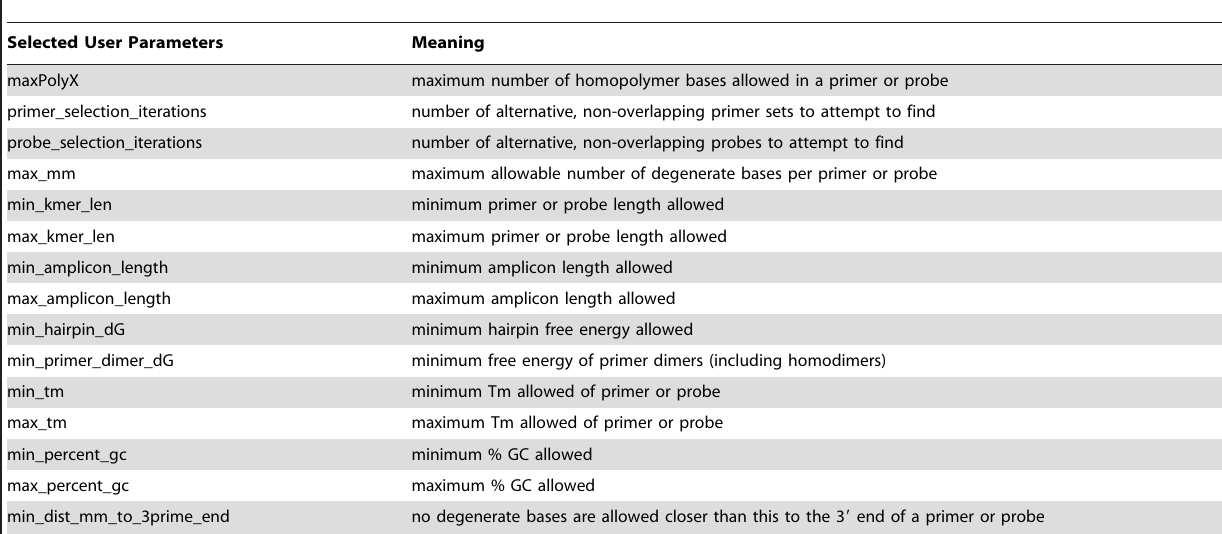
Table 1. A subset of the most commonly changed user-specifiable parameters in the options file.